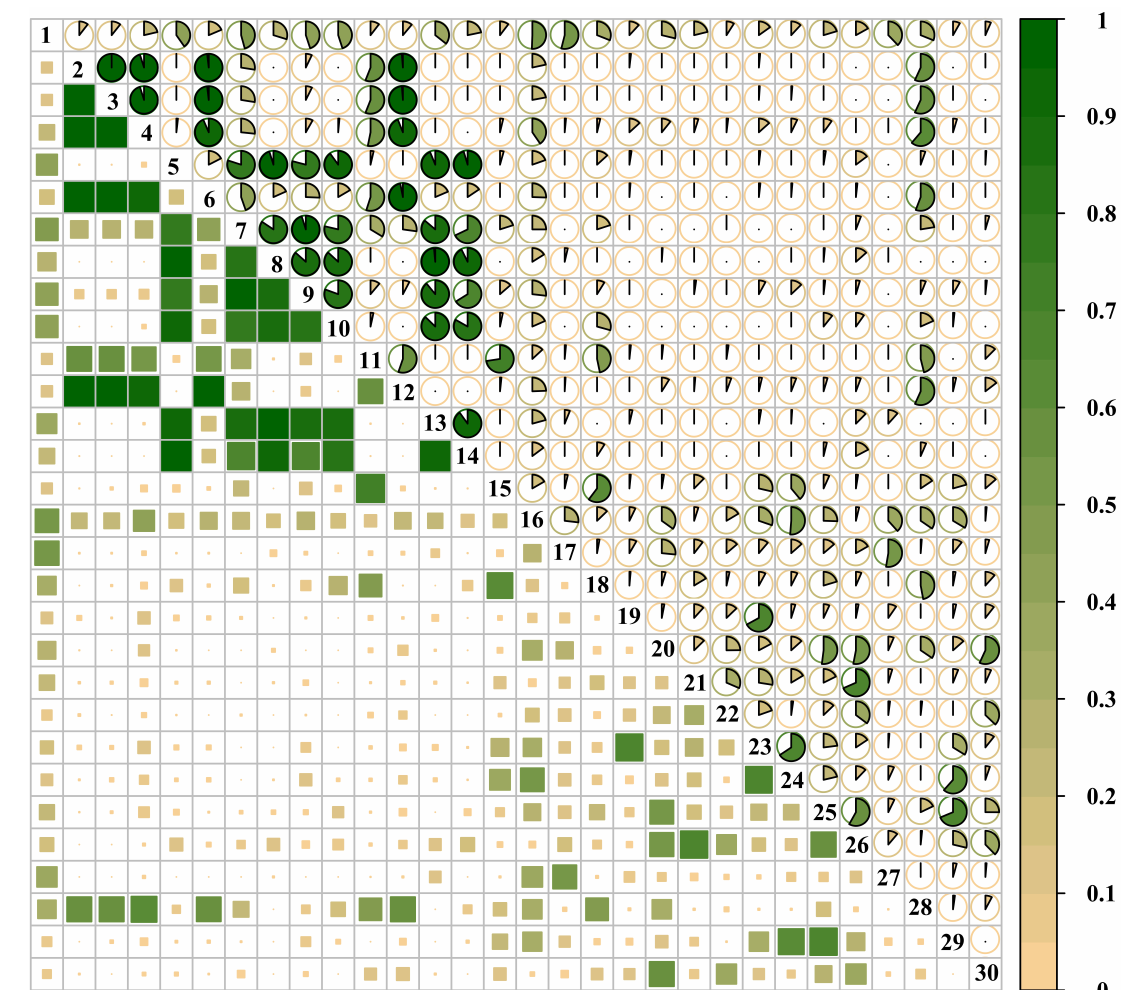
Figure 2. The ecological niche overlap index. The numbers represent the plants in Table 1. The numbers of 1 to 15 represent herbaceous plants, and 16 to 30 indicate woody plants. The larger the square or sector, the darker the color, the larger the O ik .